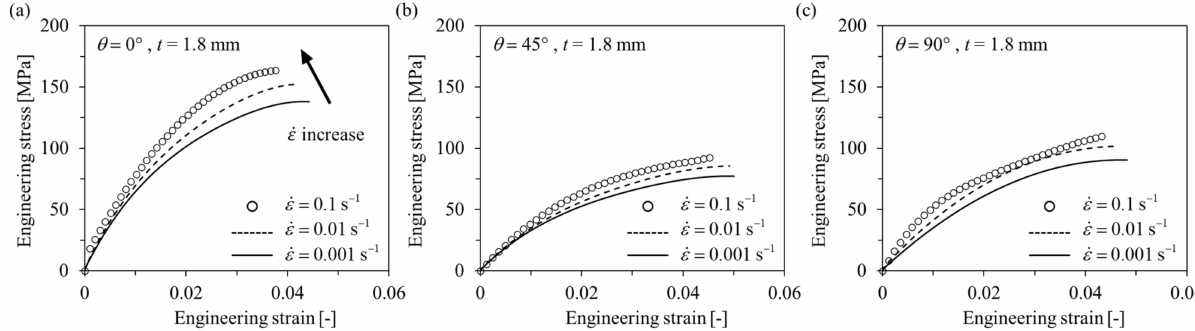
Figure 7. Compressive engineering stress–engineering strain curves of t = 1.8 mm specimens with different strain rates. ( a ) θ = 0 ◦ , ( b ) θ = 45 ◦ , ( c ) θ = 90 ◦ .